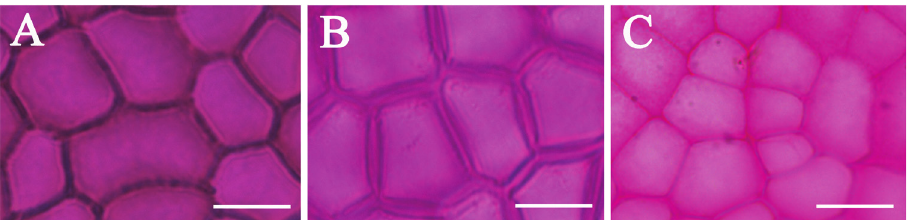
Figure 2. Leaf epidermal micromorphology of the Asian Cinnamomum , displaying the Type I upper leaf epidermis with polygonal cell shape, periclinal walls lacking reticulate ornamentations, and variable thick- ness of anticlinal walls A C. parthenoxylon B C. inunctum C C. bodinieri . Bars: 20 lygonal, the anticlinal walls straight or nearly so, and the periclinal walls not reticulate (Fig. 6A–C). The stomata are elliptic in outline, with reniform subsidiary cells, or lip- shaped with narrower subsidiary cells, the subsidiary cells usually raised. The periclinal walls of epidermal cells are slightly wrinkled and immersed in S. albidum , but raised in S. tzumu and S. randaiense .